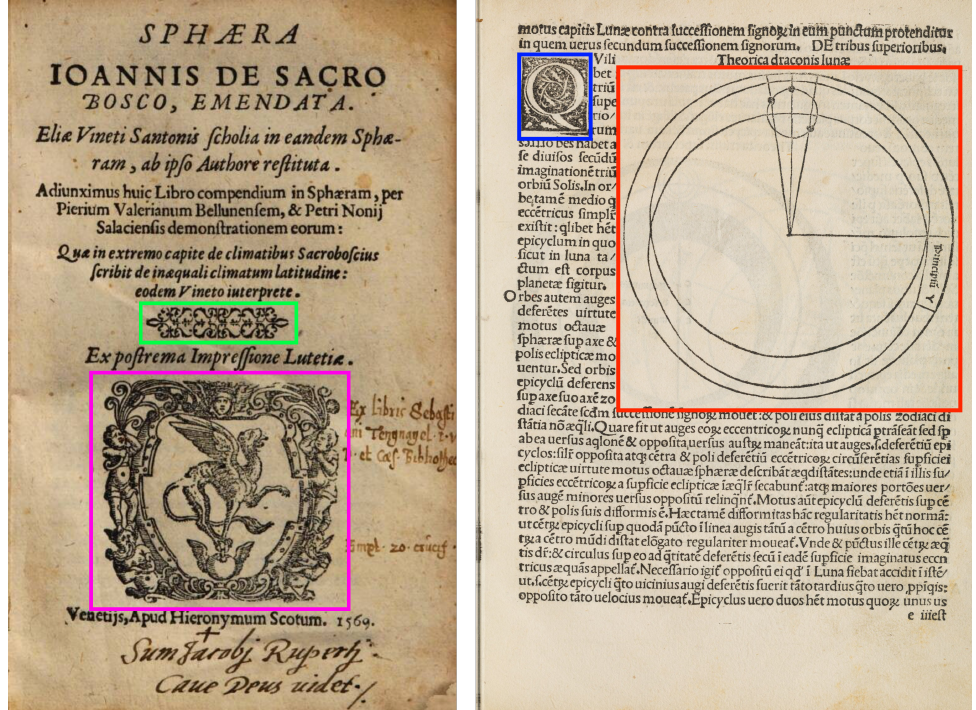
Figure 1. Two pages from the S-VED showing the four different classes. Green: Decoration, Magenta: Printer’s Mark, Blue: Initial, and Red: Content Illustration (Left page: Sphaera Ion- nis de Sacro Bosco , 1569, Venice, https://hdl.handle.net/21.11103/sphaera.101040, accessed on 2 October 2022, Österreichische Nationalbibliothek. http://data.onb.ac.at/rep/1089F5CC, ac- cessed on 2 October 2022 —Right page: Sphaerae mundi compendium foeliciter inchoat , 1490, Venice, https://hdl.handle.net/21.11103/sphaera.100885, accessed on 2 October 2022, courtesy of the Library of the Max Planck Institute for the History of